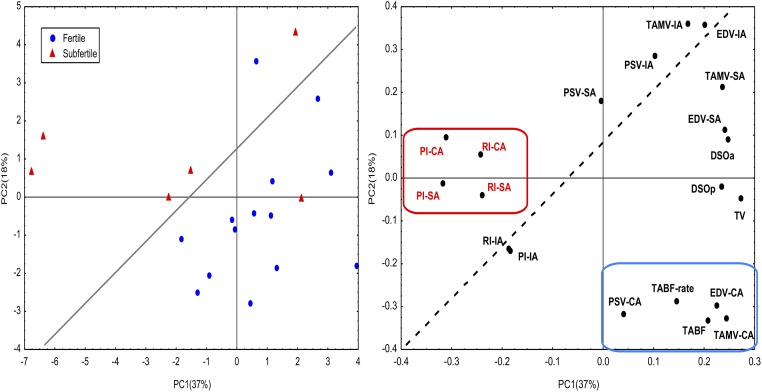
The principal component analysis assay (PCA) applied to Doppler parameters to identify fertile and subfertile stallions as described in materials and methods.Fertile stallions (1) are characterized by high values of TABF ratio, TABF, VDF and TAMV (right lower quadrant). Subfertile stallions (2) are categorized by high values of PI and RI in the supratesticular artery (TC: Testicular Cord) and in the capsular artery (PT) (left upper quadrant). (S1 File).